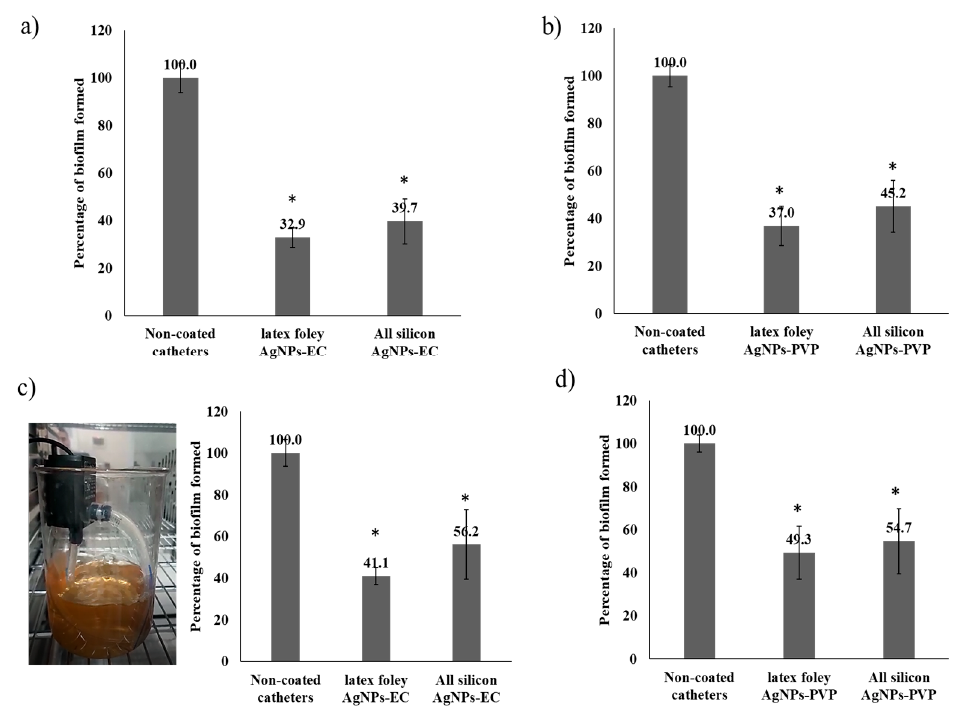
Figure 4. Effect of catheter coating on biofilm formation. ( a ) The percentage of biofilm formation on catheters coated with AgNPs-EC under static conditions. ( b ) Biofilms formed on catheters coated with AgNPs-PVP under static conditions. Panels ( c , d ) show the effect of surface coating on biofilm formation under flowing conditions. Columns show the mean values of 3 experiments ± S.D. * De-